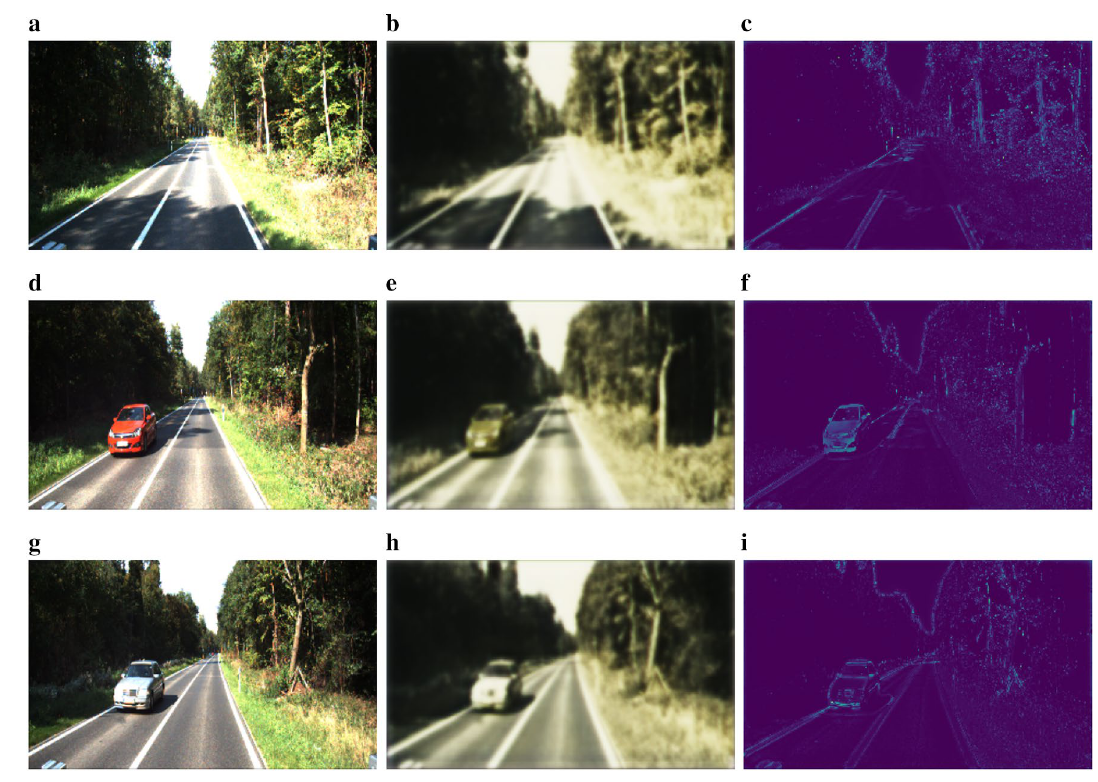
reconstruction error image for the anomalous driving scenario (red car), g input image for the anomalous driving scenario (silver car), h reconstructed image for the anomalous driving scenario (silver car), i reconstruction error image for the anomalous driving scenario (sil- ver